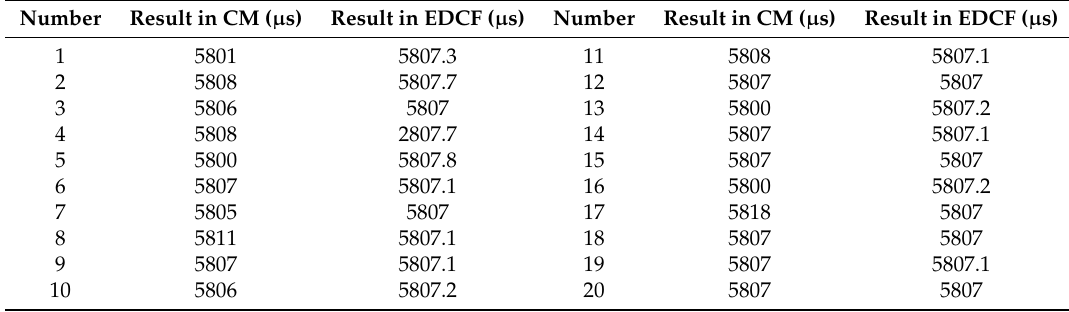
Table 1. Comparison of time delay estimation performance between the correlation method and the correlation function envelope difference